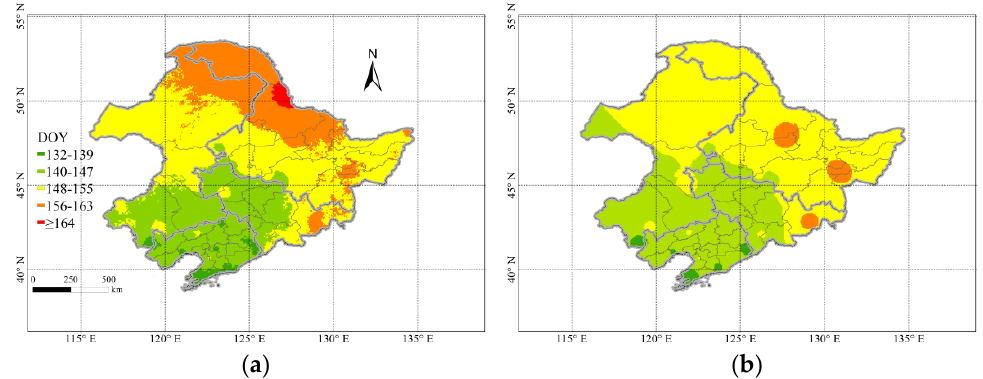
Figure 5. Three-leaf stage (V3) of maize in Northeast China (( a ) fusion data; ( b ) original data).